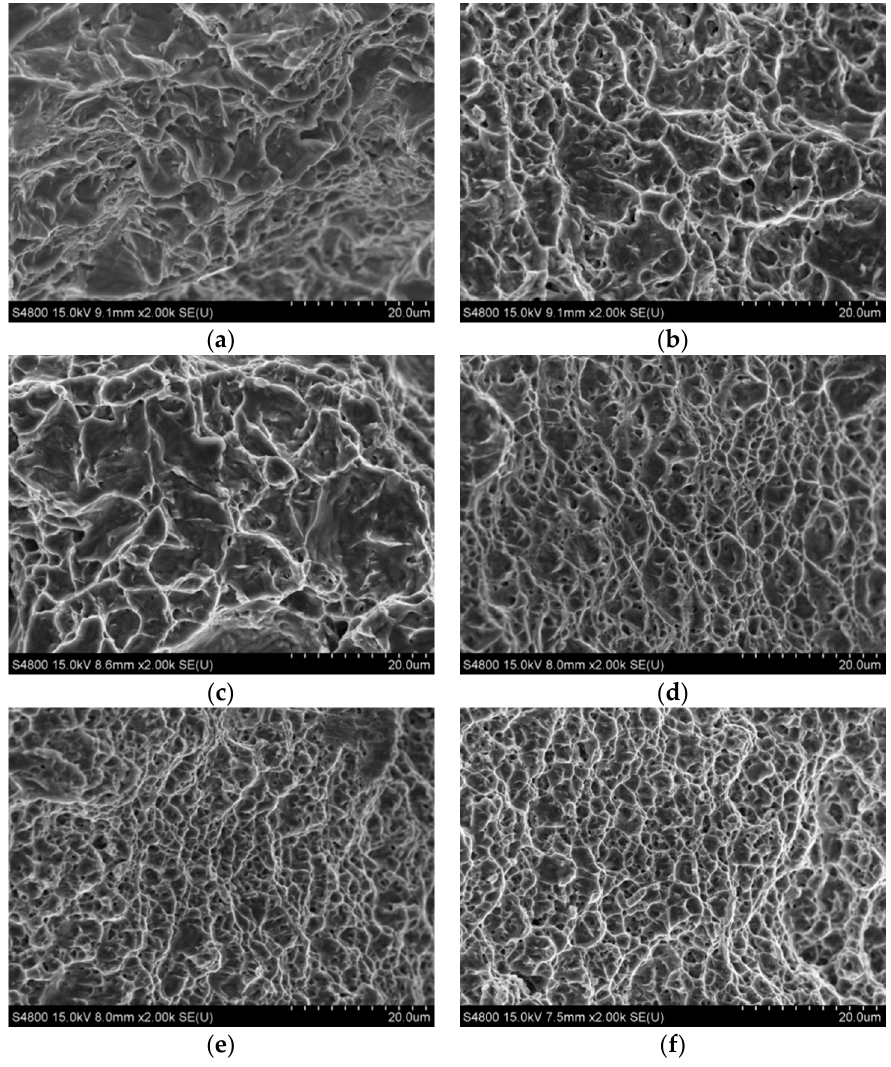
Figure 8. SEM micrographs of the tensile fracture of CP-Ti: ( a ) as-received; ( b ) 4p-ECAP; ( c ) 8p-ECAP; ( d ) as-received + CR; ( e ) 4p-ECAP + CR; ( f ) 8p-ECAP + CR.